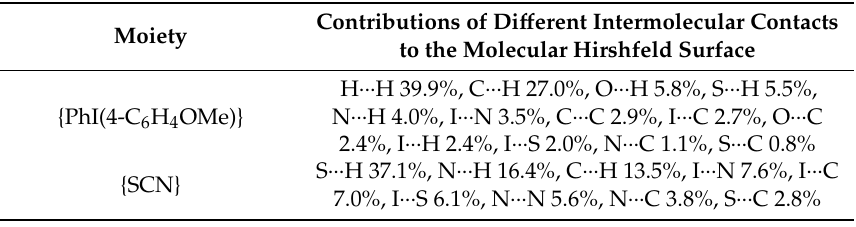
Figure 5. Shape index surfaces (top, color code: hollow–red; bumps–blue) and curvedness index surfaces (bottom, color code: edges–blue; flat regions–green) plotted over the Hirshfeld surfaces of [PhI(4-C 6 H 4 OMe)] + and SCN – ions in the crystal structure of 1 .